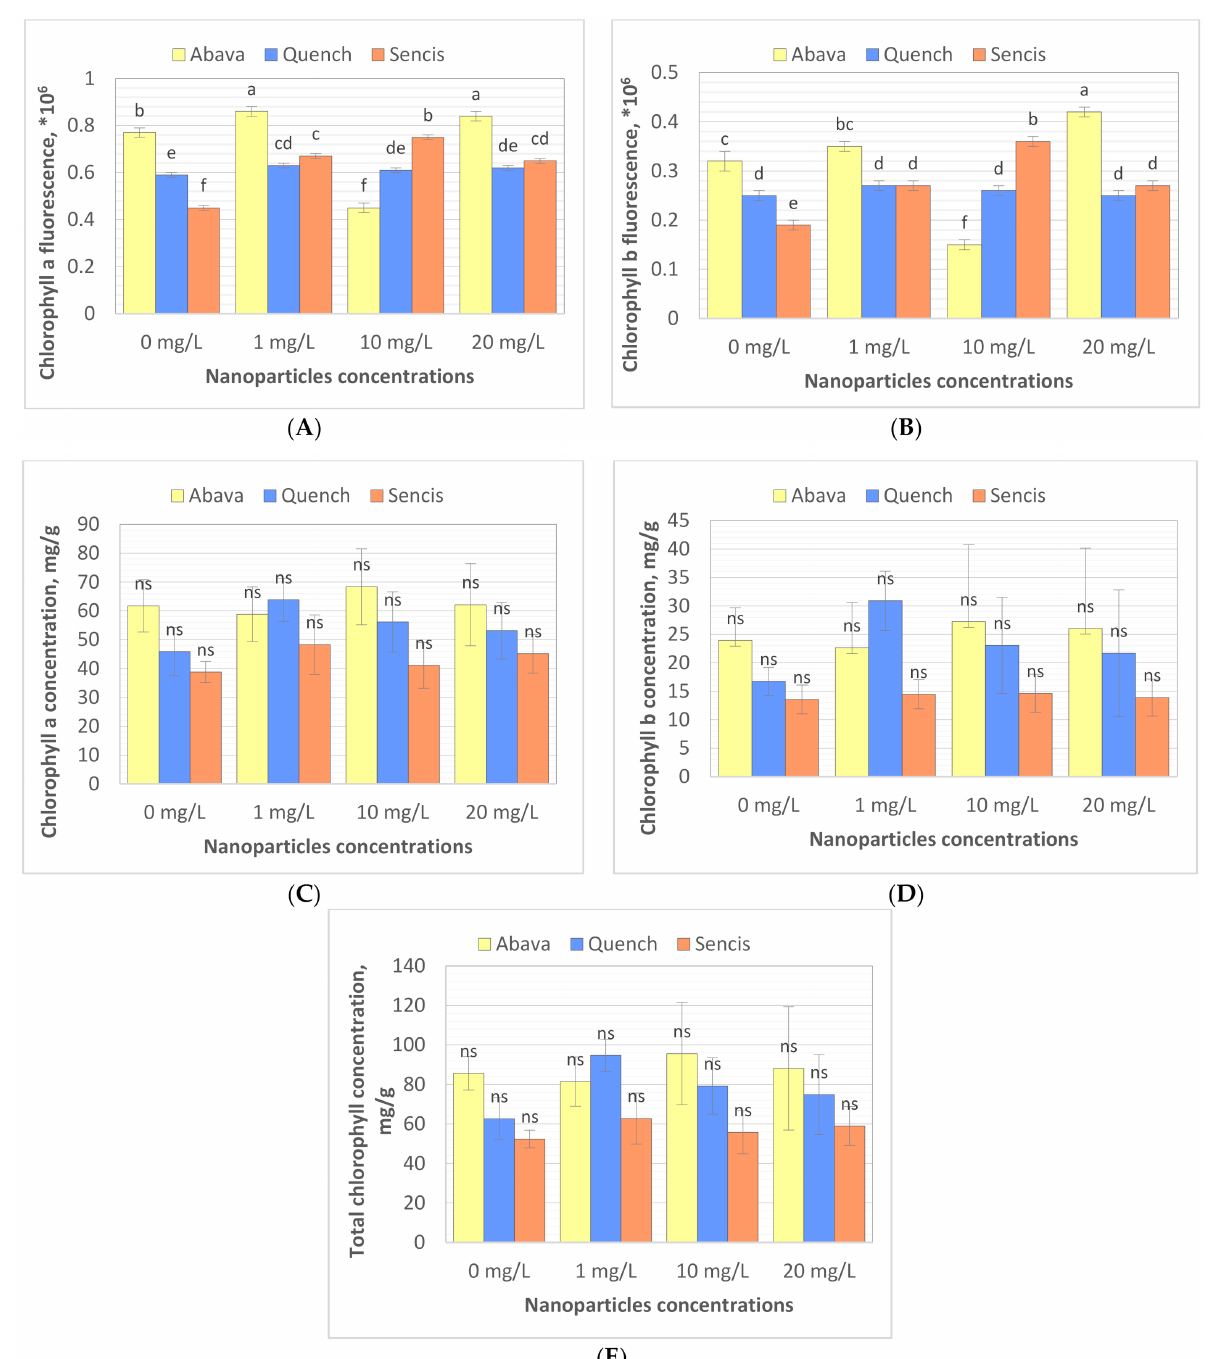
Figure 4. Effects of different Fe 3 O 4 nanoparticle concentrations on chlorophyll a, and b fluorescence ( × 106) ( A , B ), content (mg/g) ( C , D ), and total chlorophyll concentration (mg/g) ( E ) in treated three H. vulgare L. seedlings expressed as the % of control. Values are the mean of three replicates with SD. Different letters within each bar indicate significant differences at p < 0.05 and the same letters or ‘ns’ indicate no significant difference (Tukey’s test—two-way analysis of